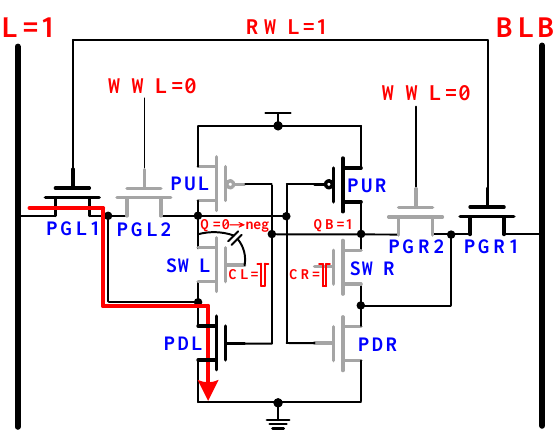
Figure 4. The read operation of proposed 10T cell.